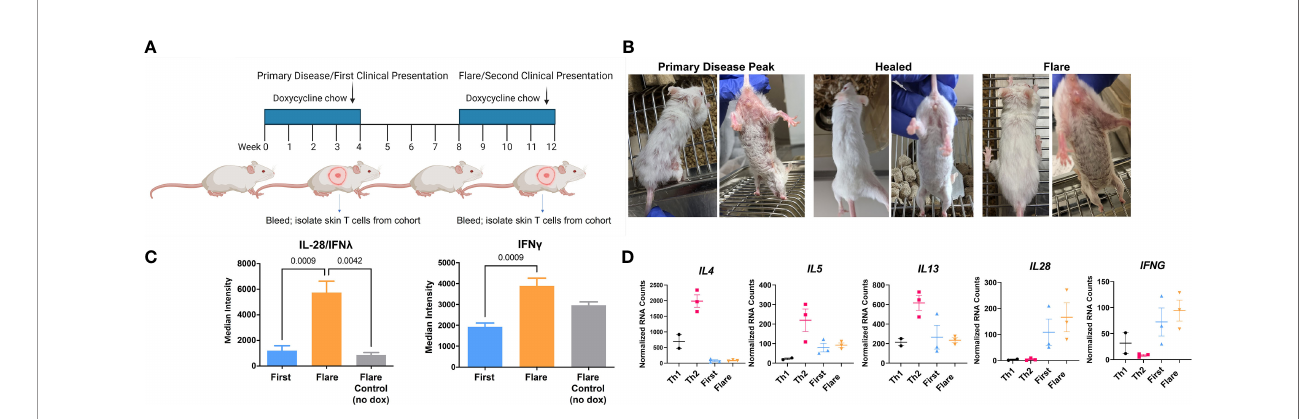
FIGURE 4 | In vivo acquired Th1 phenotype is maintained by memory T cells. (A) CLE fl are model diagram created with BioRender.com. (B) Sample clinical photographs of initial induction and reinduction of skin lesions. (C) RayBiotech array analysis of serum from mice at the time of the initial occurrence of skin lesions and the reinduction of skin lesions. (D) Comparison of in vitro activated T cells and KJ-126+ T cells recovered from the initial and reinduced skin lesion by NanoString gene expression analysis (n=2-3 cultured cell batches and 3 mice per group pooled from 2 independent